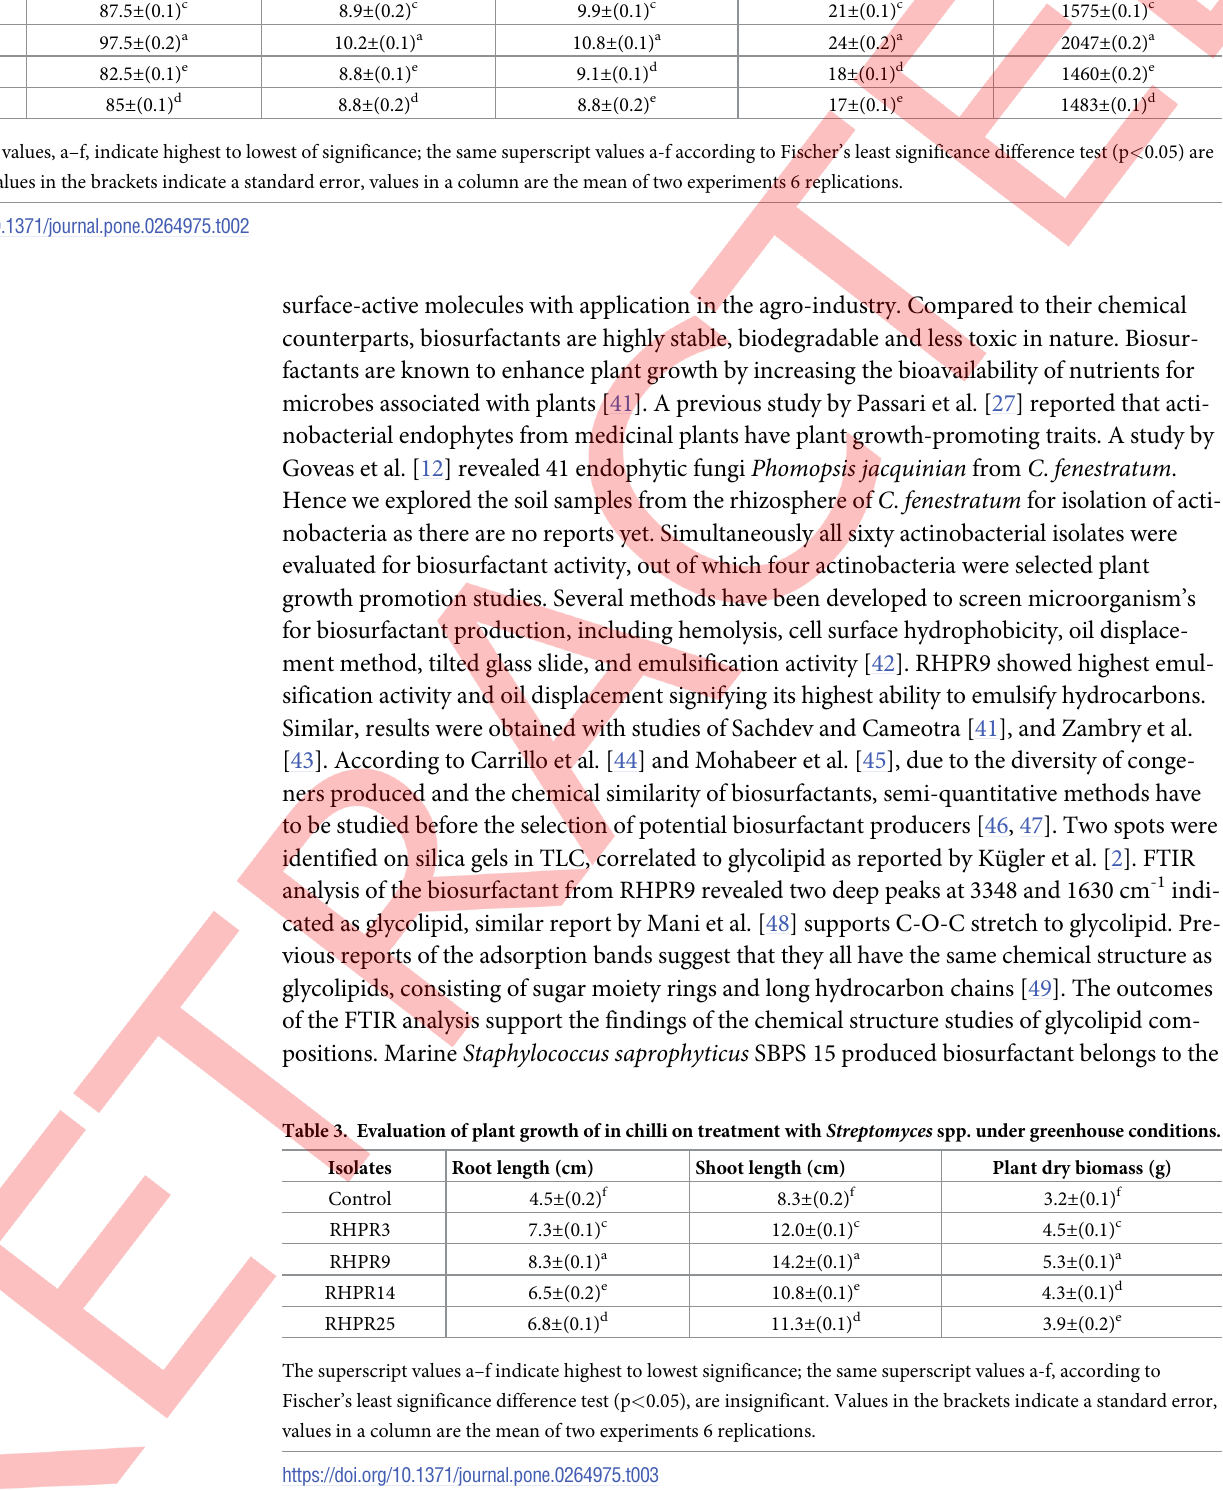
Table 2. Evaluation of seed germination in chilli seeds on treatment with Streptomyces spp. by paper towel method. Isolates